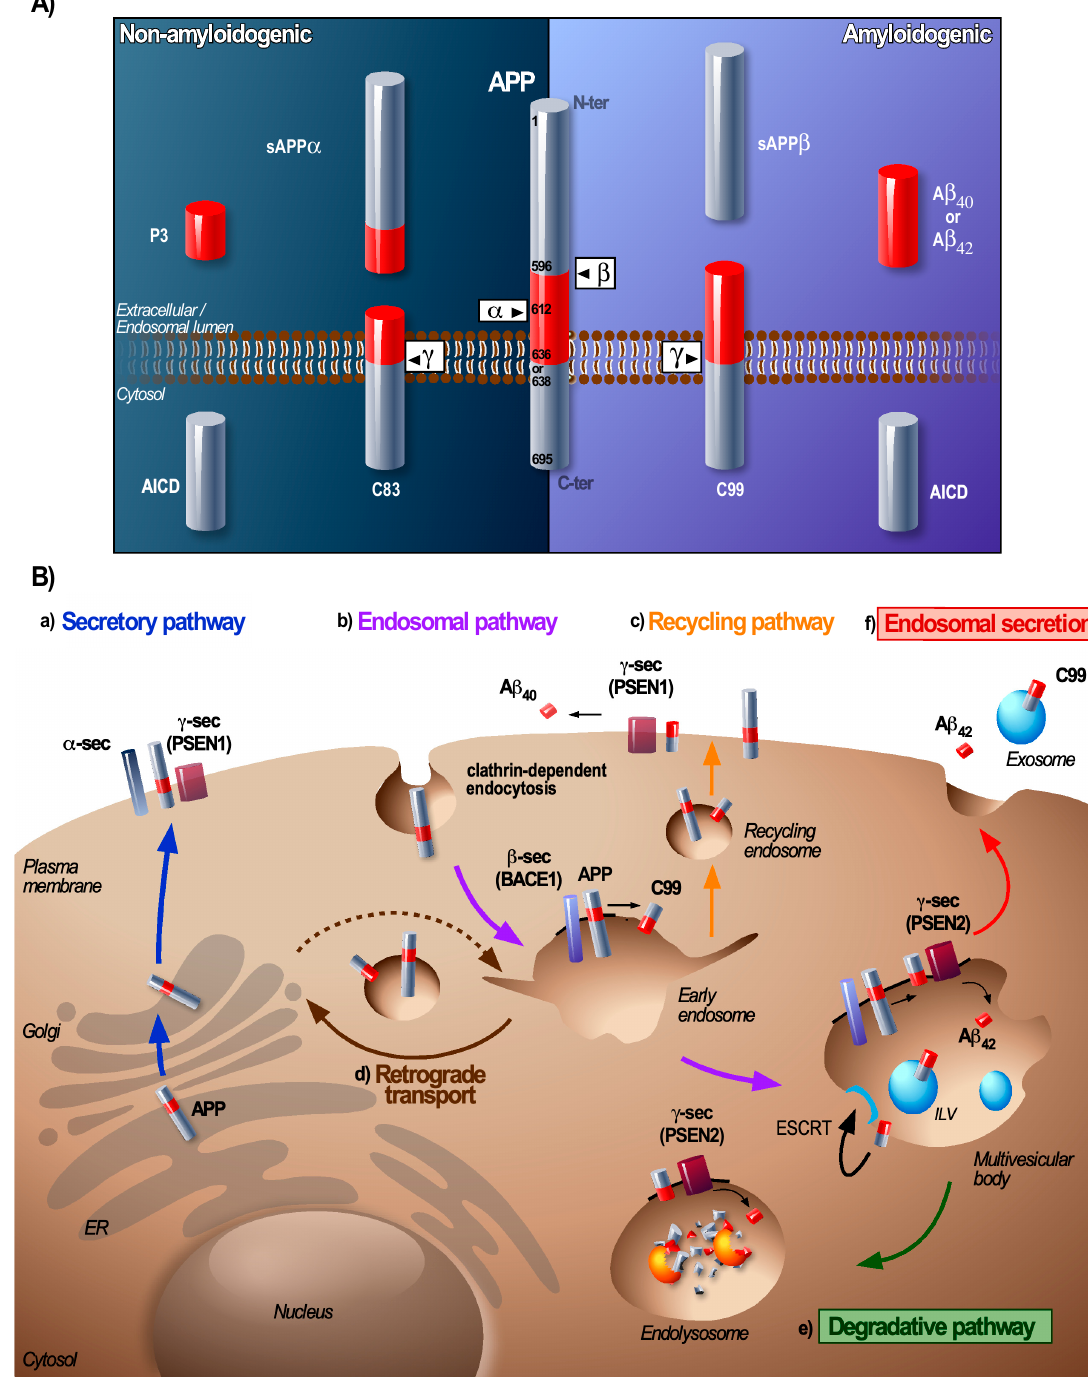
Figure 1. Processing and trafficking of amyloid precursor protein (APP) through the endolysosomal pathway. ( A ) Canonical processing of APP. Under physiological conditions, APP is preferentially processed through the non-amyloidogenic pathway (left panel). During non-amyloidogenic processing, APP undergoes a first cleavage by the α -secretase (mainly ADAM10) within the A β domain (red portion) that releases a soluble sAPP α fragment and the membrane-anchored C83 fragment (also called CTF α ). The γ -secretase complex then cleaves C83 resulting in the release of a small P3 peptide and the intracellular APP intracellular domain (AICD) fragment. The amyloidogenic pathway (right panel) is responsible for the production of A β . Under physiological conditions, this pathway is active but only a minority of the total APP is processed this way, during AD however, the metabolism of amyloids by this pathway is increased. The amyloidogenic pathway involves a first